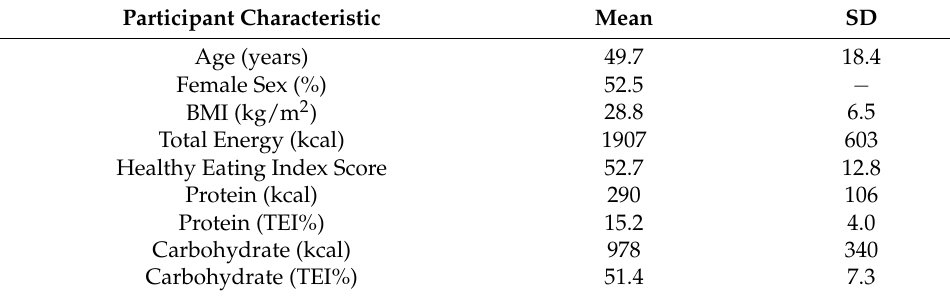
Table 1. Participant characteristics